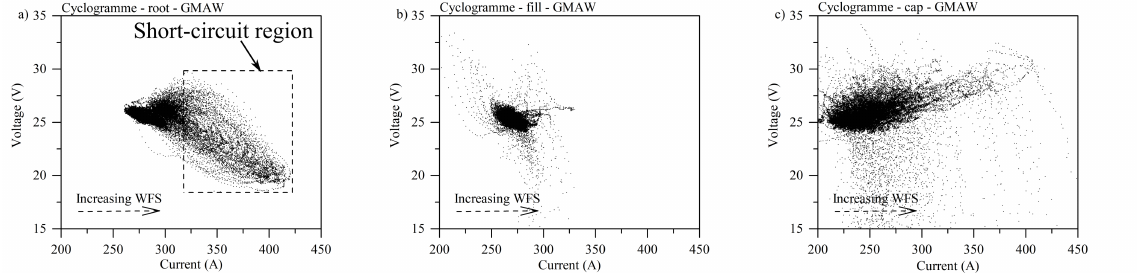
Figure 4. Cyclogrammes for the GMAW specimens: ( a ) root pass; ( b ) fill pass; and ( c ) fill pass.